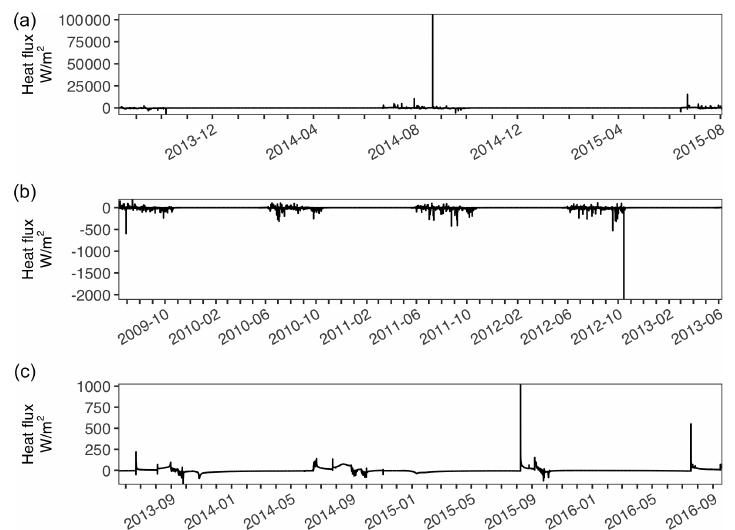
Figure C3. Downward heat flux at the bottom of the water column over the baseline simulation period for Atqasuk (a) , Fox Den (b) , and Toolik Lake (c) .